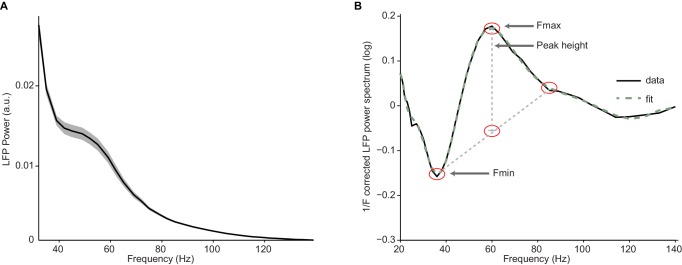
Illustration of fitting procedure.(A) Average LFP power spectra for a large chromatic condition of an example session used in Figure 2. LFP spectra for all conditions were normalized to the summed power (>20 Hz) for the baseline condition (see Materials and methods). (B) Log-transformed, 1/Fn corrected spectra (solid line) and their fit (dashed line). Peak height was determined as the difference between the peak value at location Fmax and a baseline estimate based on the average of the power at location Fmin and Fmin +2*(Fmax-Fmin), the estimate of peak width.